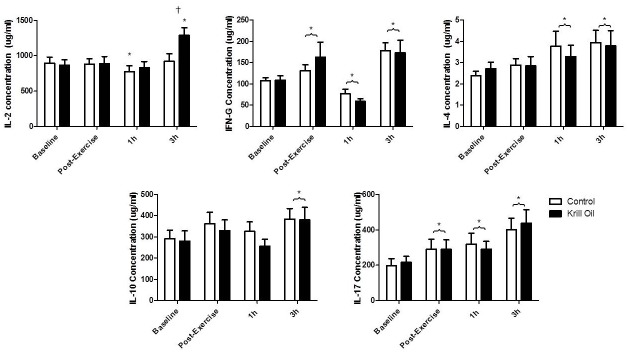
The effect of 6 weeks krill oil/placebo supplementation on exercise induced cytokine production by PBMCs stimulated with concanavalin A.* indicates significant difference (P<0.05) from baseline values. † indicates significant difference (P<0.05) between groups.